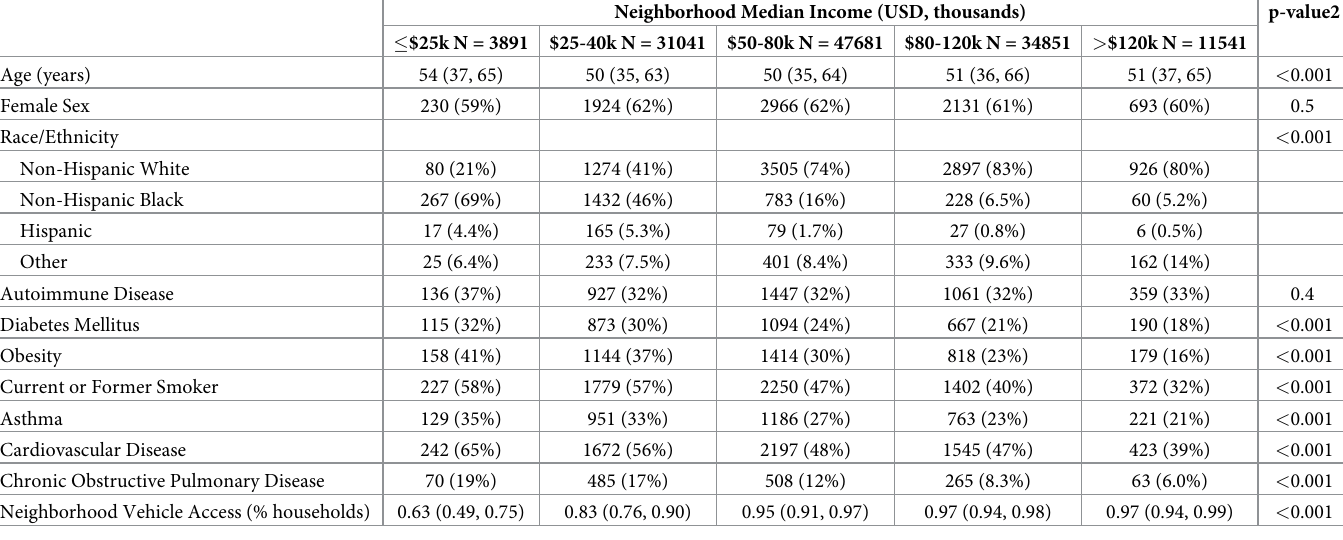
Table 1. Sociodemographic and clinical characteristics of patients who met study inclusion criteria, by levels of 2018 neighborhood median income corresponding to census tracts of residence in Northeastern Ohio. Neighborhood Median Income (USD,